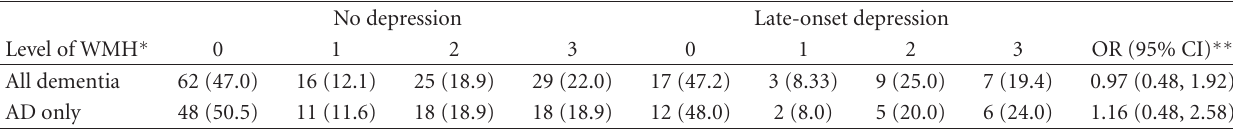
Table 5: risk of subcortical white matter hypodensities in late-onset depression compared with no depression for all dementia and Alzheimer’s disease